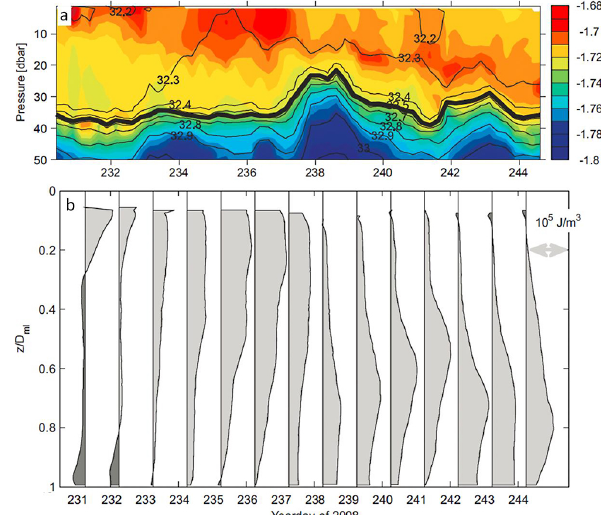
Fig. 12. In (a) contours of temperature ( ◦ C, color shading) and salinity (psu, solid black), and in (b) daily difference profiles of heat content (Jm − 3 ) for subsequent 24h averaged profiles relative to DoY 230.25; depth is normalized by the mixed layer depth for each profile. Light grey shading indicates heat gained from the first profile, and dark grey shading indicates heat lost from the first pro- file. The thick black line in (a) indicates the base of the mixed layer. Figure is adapted from Sirevaag et al.